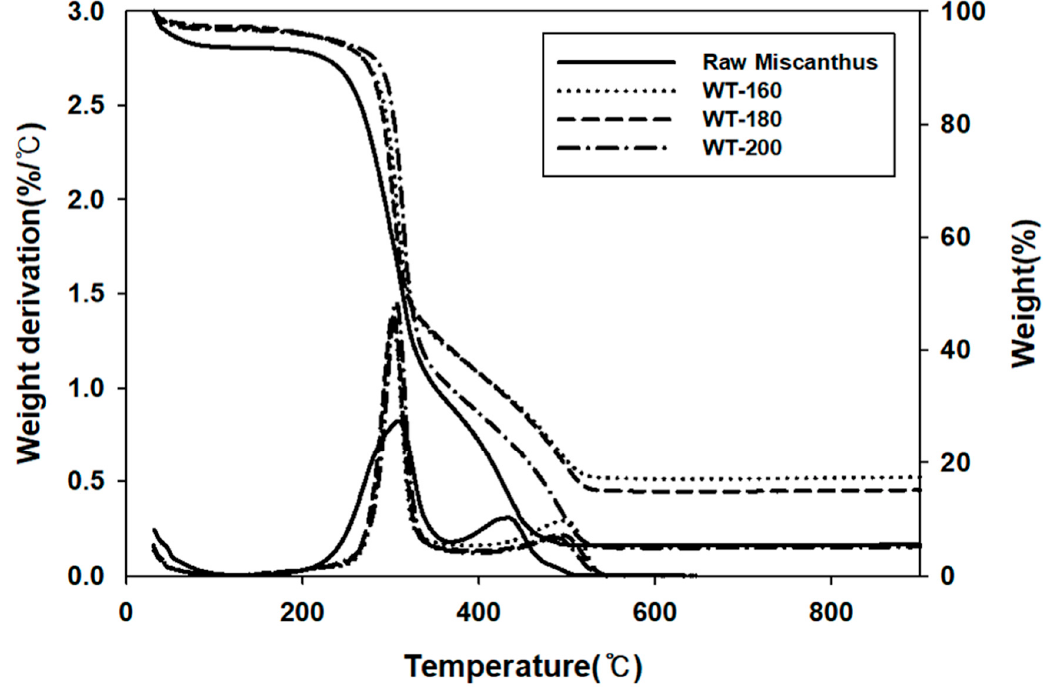
Figure 4. TG-DTG curves of Raw Miscanthus (RM) and WT-samples during the combustion.